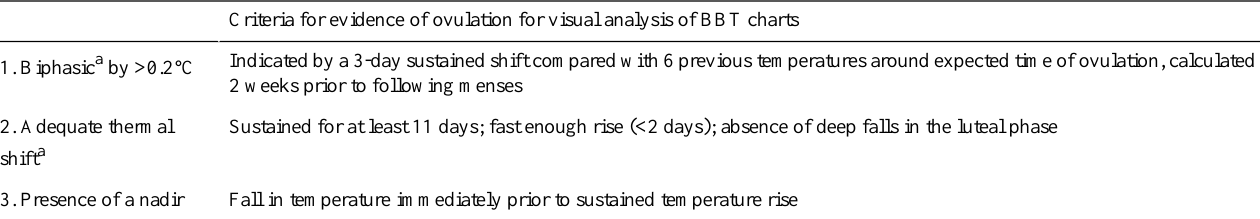
Table 1. Outline of criteria used for evidence of ovulation when visually analyzing temperature charts of temperature recorded using the digital oral thermometer and BMSW. Criteria for evidence of ovulation for visual analysis of BBT